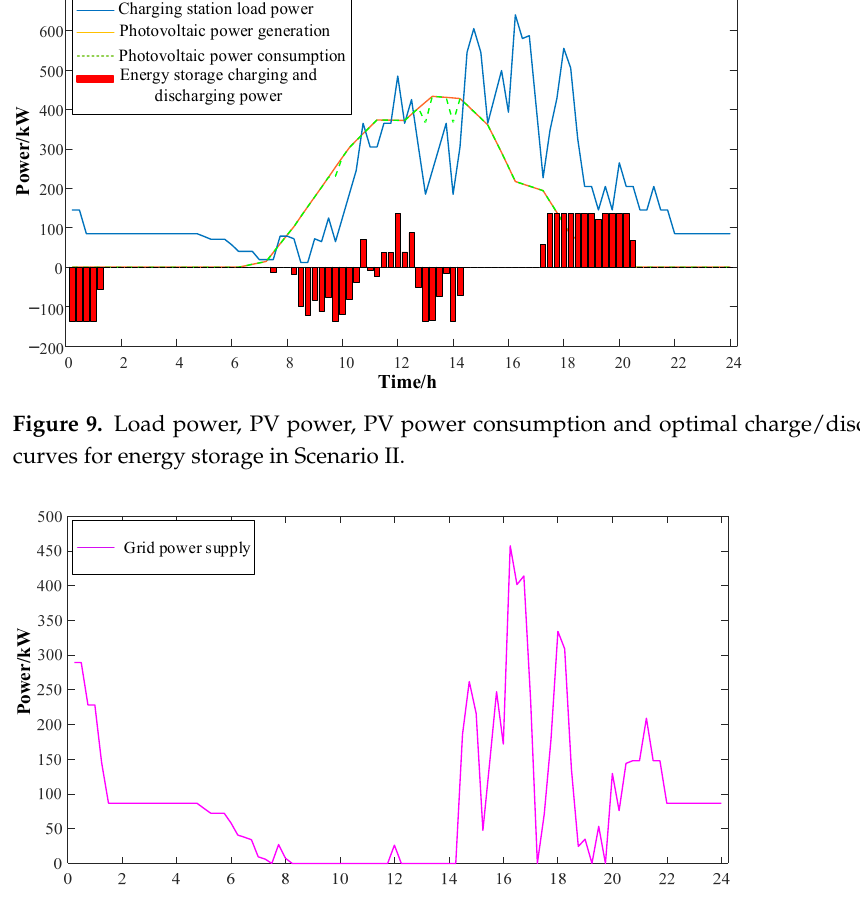
Figure 10. Power curve of grid supply in scenario II.